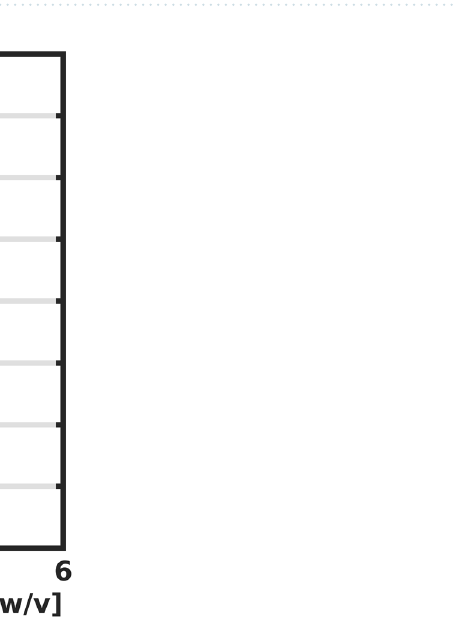
Figure 3. Synthesis yields for different concentrations of boric acid (A) and NMR analysis of the interaction between HEMA and boric acid (B,C) .